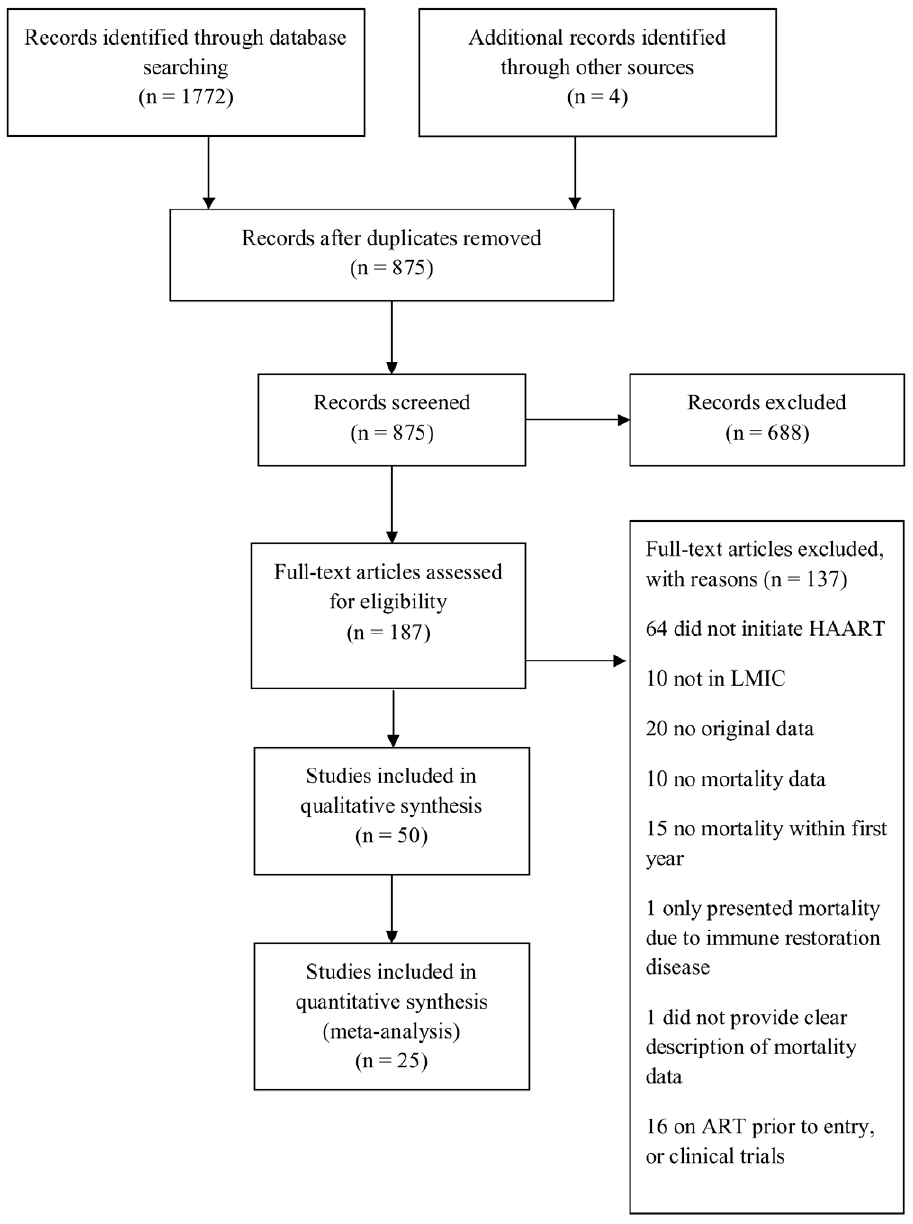
Figure 1. Study selection process and reasons for exclusion of studies. Flow chart constructed using the PRISMA guidelines (Moher D, Liberati A, Tetzlaff J, Altman DG, The PRISMA Group (2009). P referred R eporting I tems for S ystematic Reviews and M eta- A nalyses: The PRISMA Statement. PLoS Med 6(6): e1000097. doi:10.1371/journal.pmed1000097).